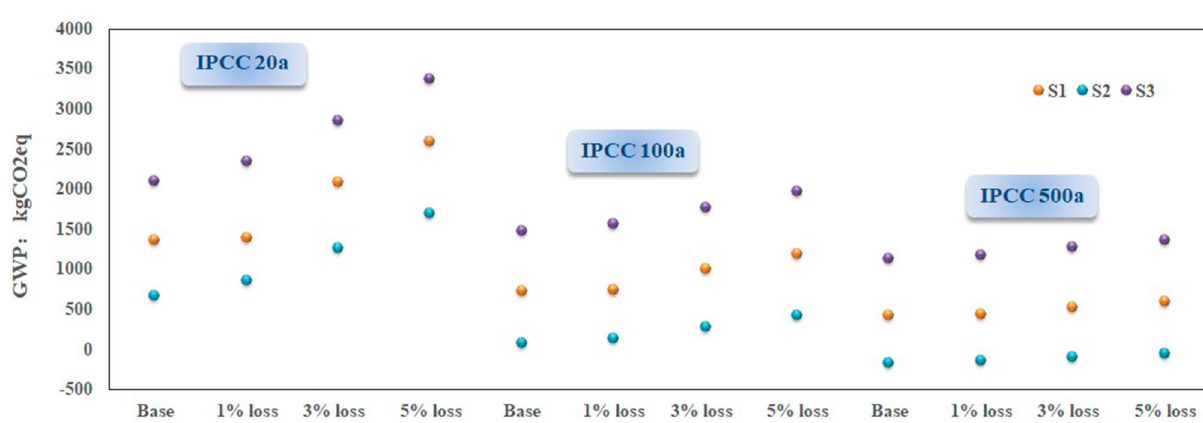
Figure 6. The sensitivity results of each system with IPCC assessment method under the situation of methane loss ratio